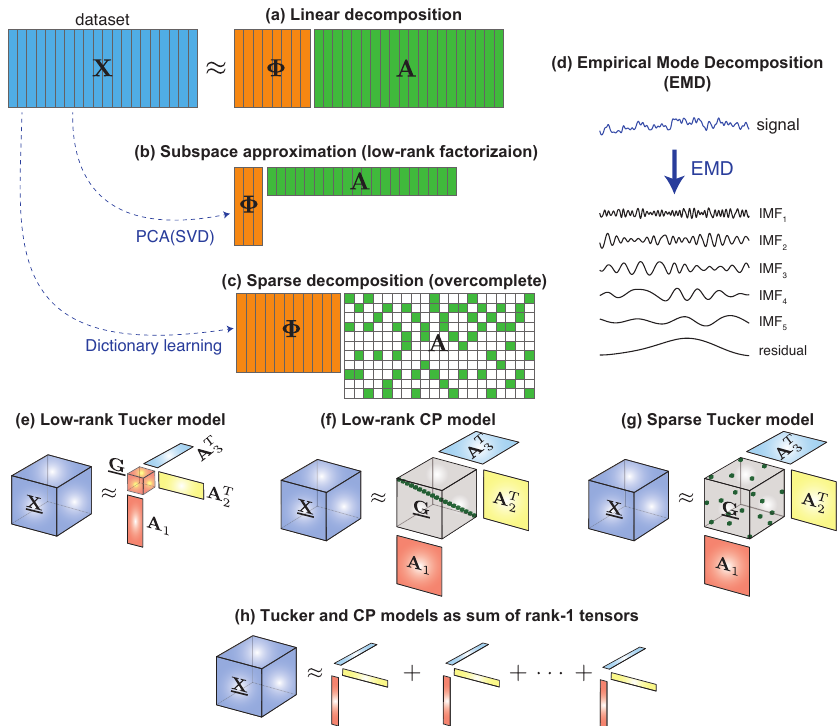
Figure 1. Decomposition models. ( a ) General linear model : a collection of vector data samples organized as columns of a matrix dataset X is approximated by the product of matrices Φ and A . ( b ) Subspace approximation: all vectors in the dataset are approximated by linear combination of few vectors (principal components). ( c ) Sparse coding : each vector in the dataset is approximated by the linear combination of atoms (columns of a dictionary Φ ). In both, ( b , c ), the optimal choice of matrix Φ can be computed from the dataset itself by means of the SVD and an dictionary learning algorithm, respectively. ( d ) EMD : every single signal is decomposed as a sum of characteristic modes. Tensor decomposition models such as Low-rank Tucker ( e ), Low-rank CP ( f ) and Sparse Tucker ( g ) can be written as sum of rank-1 tensors ( h